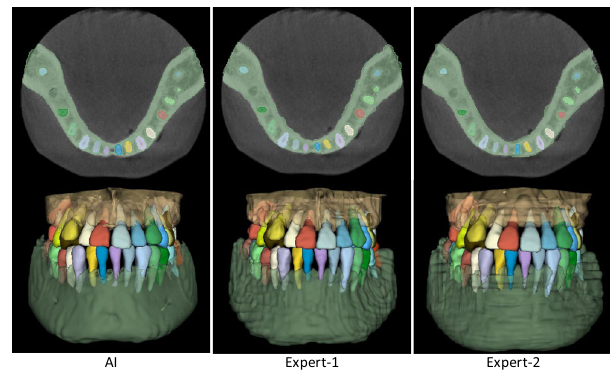
Fig. 5 Qualitative segmentation results produced by our AI system and two